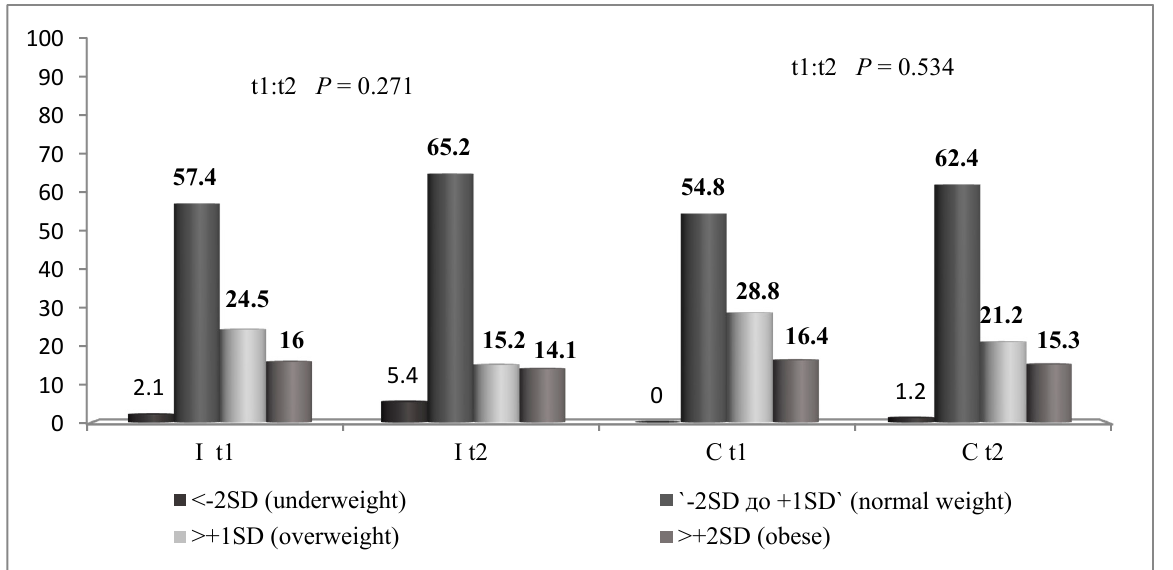
Figure 4. Weight status of the participants from the I group and the C group in t1 and t2.